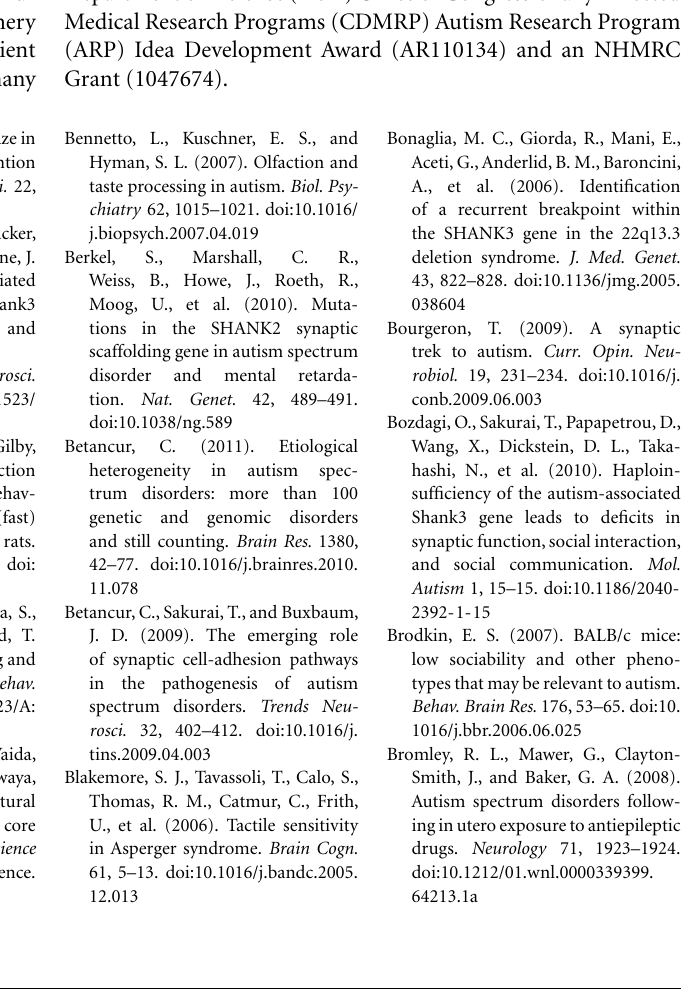
Table 3 ). Both environmental models (i.e., rodents administered the fatty acids valproate and PPA) and phenotype first models show heightened seizure susceptibility and anxiety-like behaviors together with sensory and motor deficits ( Table 3 ). In